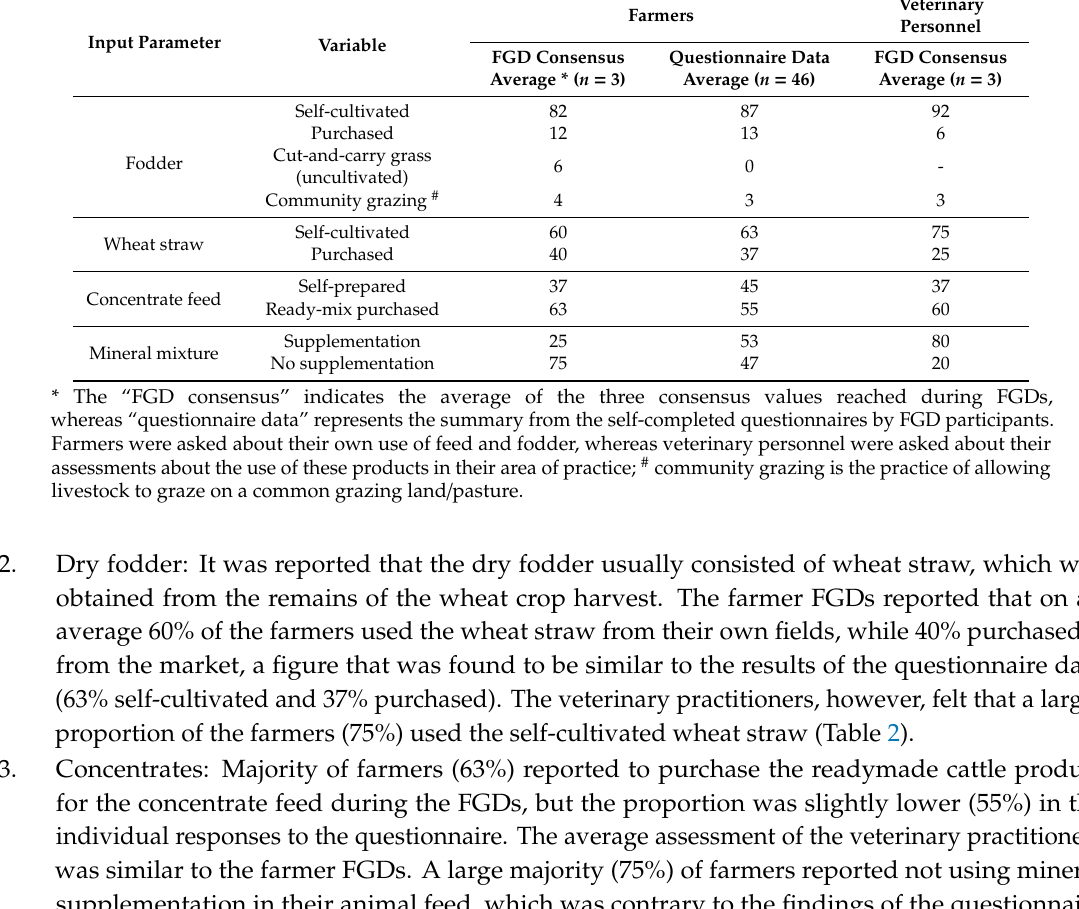
Table 2. Input value chain component of feed and fodder displaying the proportion (%) of various input types based on the focus group discussions (FGDs) conducted in Punjab, India in 2018–2019. Input Parameter Variable Self-cultivated 82 Fodder (uncultivated) Community grazing # Self-cultivated 60 Wheat straw Self-prepared 37 Concentrate feed Supplementation 25 53 80 Mineral mixture No supplementation 75